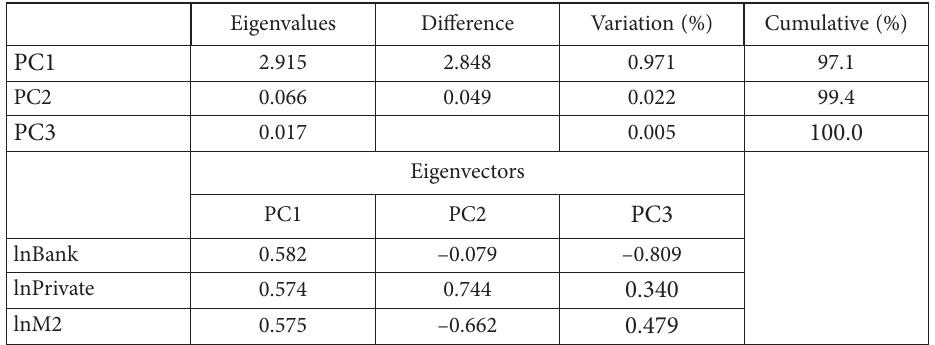
Table 2. Financial development index